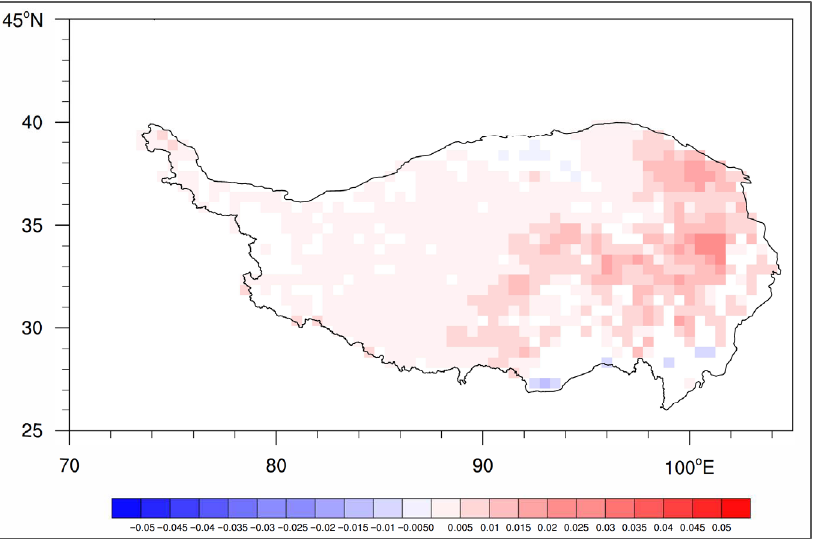
Figure 8. Spatial distributions of the linear trend of GLASS LAI during the growing season.